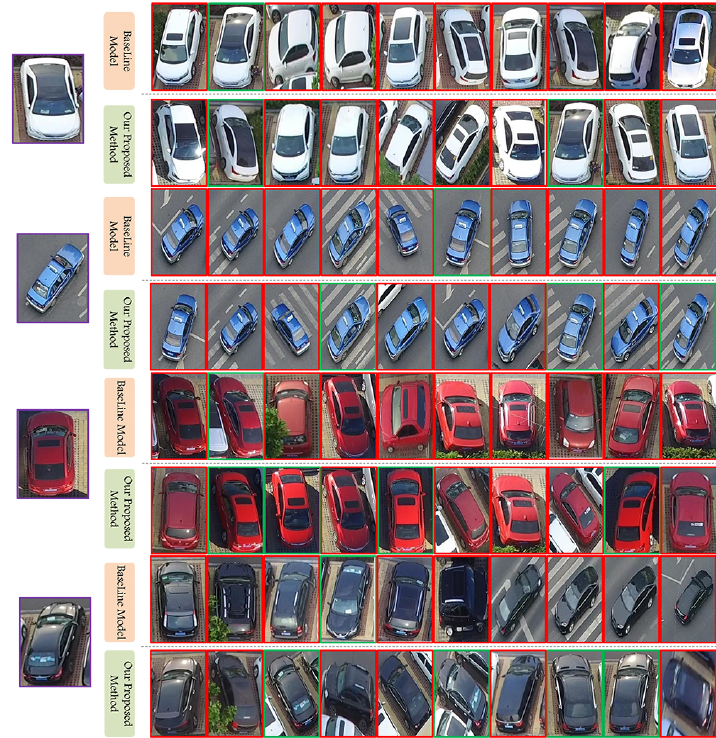
Figure 8. Parts of visual object Re-ID results on the UAV Re-ID using the baseline module and the HP-SET-Attn configuration of the proposed AAD-CPGE framework.